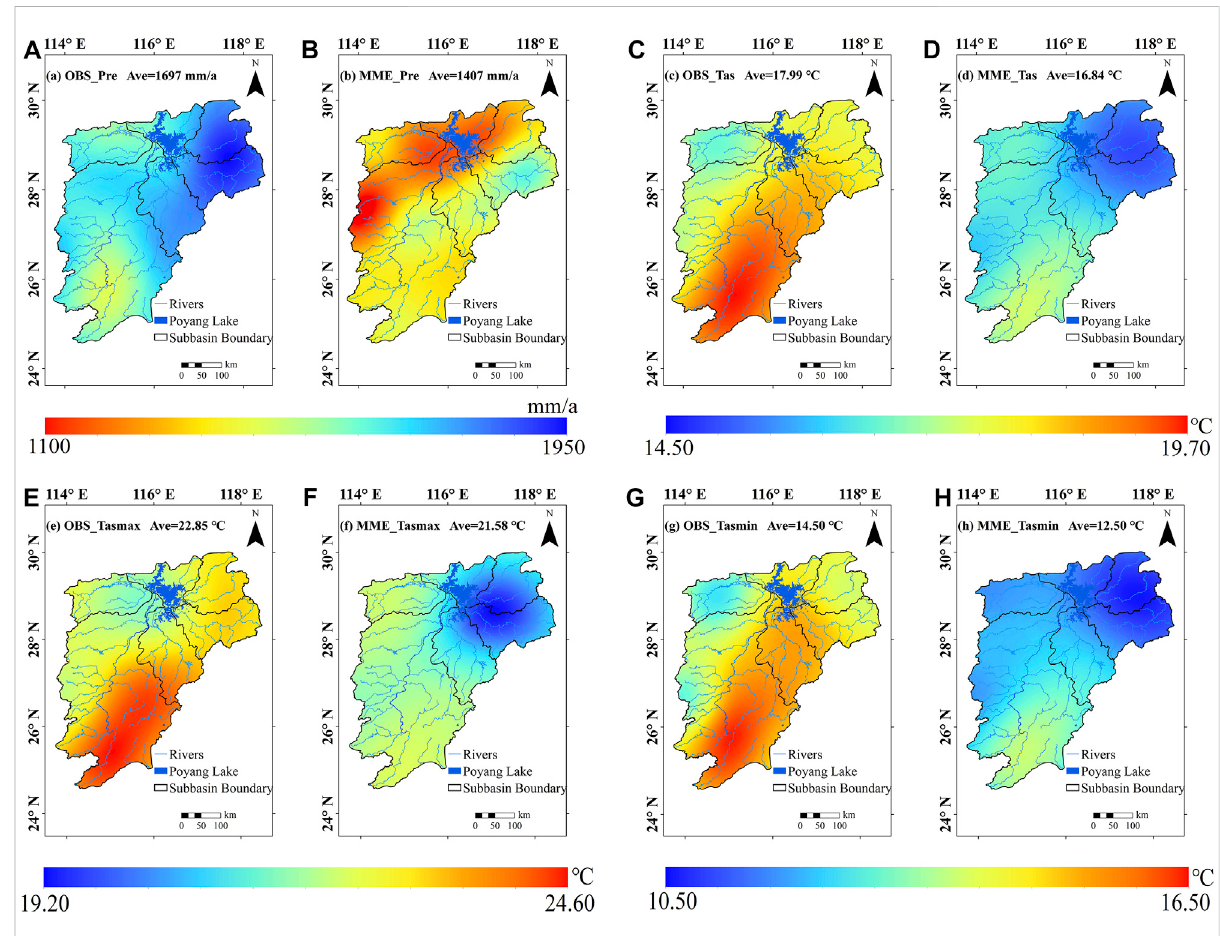
FIGURE 4 CMIP6 multi-model ensemble precipitation and temperature spatial distribution simulation of observation data. (A,C,E,G) are the observed precipitation, Tas, Tasmax and Tasmin of the PLB. (B,D,F,H) are the simulated precipitation, Tas, Tasmax and Tasmin of the CMIP6.